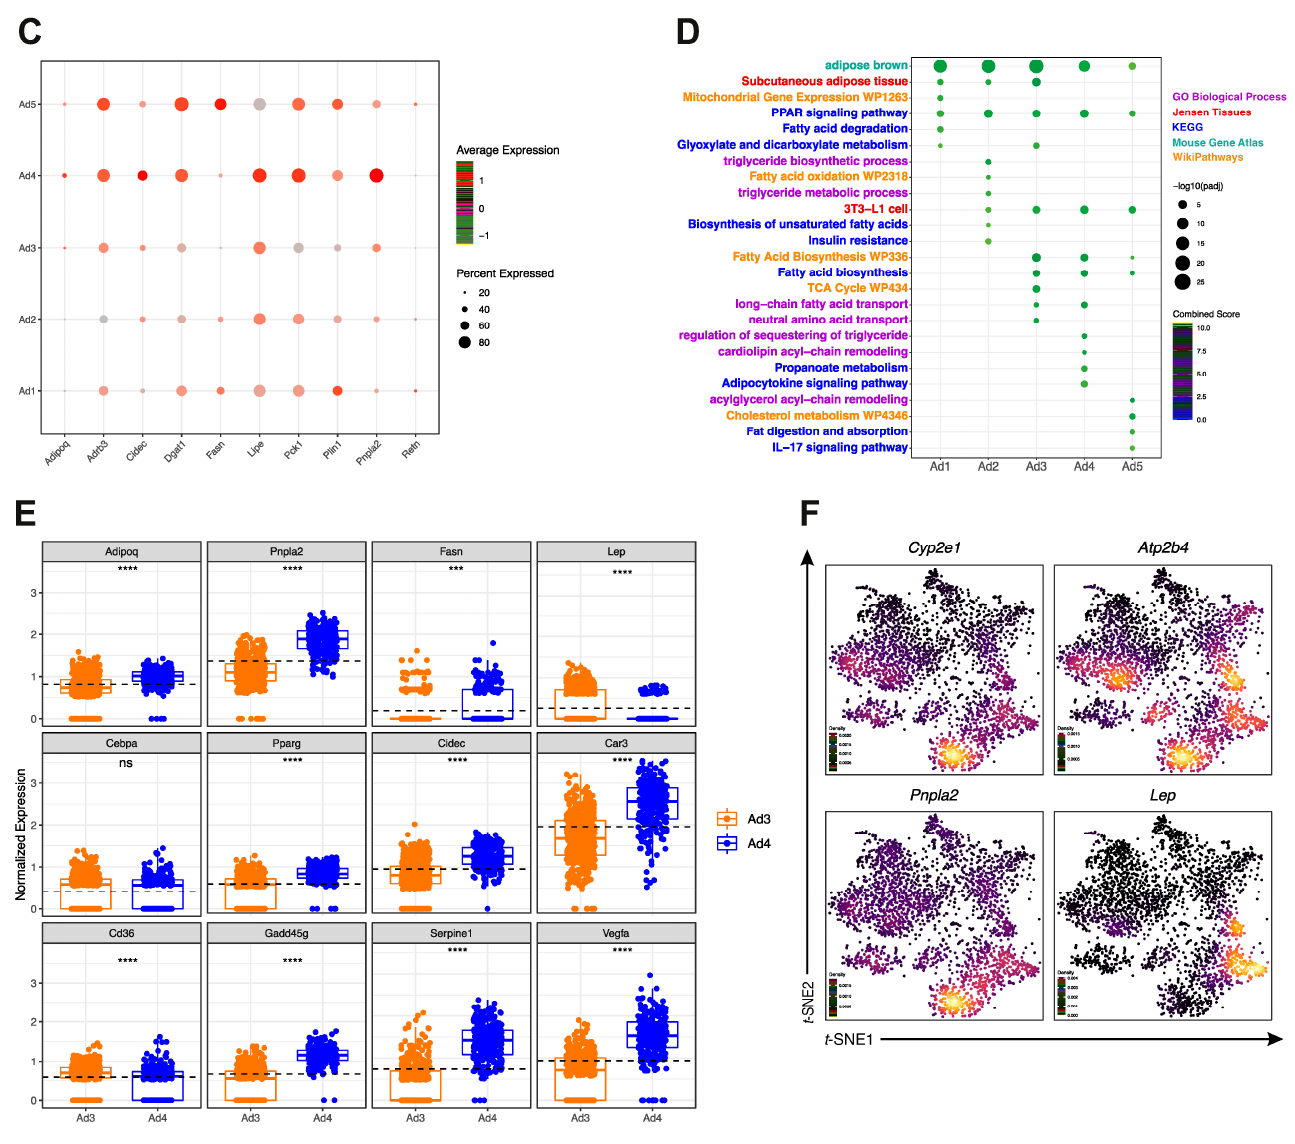
Figure 2. Multidimensional workflow template identifies two distinct mature adipocyte subclusters at RT. ( A ) Reclustering of adipocytes nuclei using SCCAF identified 5 putative adipocyte subclusters from “fat cake” iWAT nuclei data (Ad1 = 1539 nuclei; Ad2 = 1106 nuclei; Ad3 = 477 nuclei; Ad4 = 265 nuclei and Ad5 = 181 nuclei). ( B ) Gene-expression heatmap of the top 10 most DEGs in each adipocyte subcluster compared to all others. Genes are represented in rows and cell clusters in columns. ( C ) Gene-expression dot plot of the canonical adipocyte markers for each adipocyte subcluster. Rows depict clusters, while columns depict genes. The intensity of any given point indicates average expression, while its size represents the proportion of cells expressing a particular gene. ( D ) Selected top categories from ORA analysis of DEGs from the five adipocyte clusters. The intensity of the color in the dotplot indicates the enrichment significance by the combined score. Circle sizes correspond to the -log10 adjusted p -value (padj). Gene set names are colored according to the GO biological process (purple), Jensen tissues (red), Kyoto Encyclopedia of Genes and Genomes (KEGG, blue), Mouse Gene atlas (green), and WikiPathways (orange). ( E ) Scatter-box plot representing normalized gene expression of 12 marker genes in the two adipocyte clusters from RT (Ad3 and Ad4 subclusters). At the top of each box is the significance of the comparison between Ad3 and Ad4 subclusters. ns, non-statistical significance, *** p < 0.005, **** p < 0.0001. ( F ) Nebulosa expression plots representing four markers ( Cyp2e1 , Atp2b4 , Pnpla2 and Lep ). Ad3 and Ad4 subpopulations correspond to adipocytes present in fat cake of iWAT of non-treated mice (Control, RT) (Figure 2A). A comparison of adipocyte canonic markers revealed that Ad4 expresses higher levels of Adipoq , Plpna2 , Fasn , Pparg , Cidec , Car3 , and Gadd45g than Ad3 at room temperature (Figure 2E) suggesting that Ad4 more